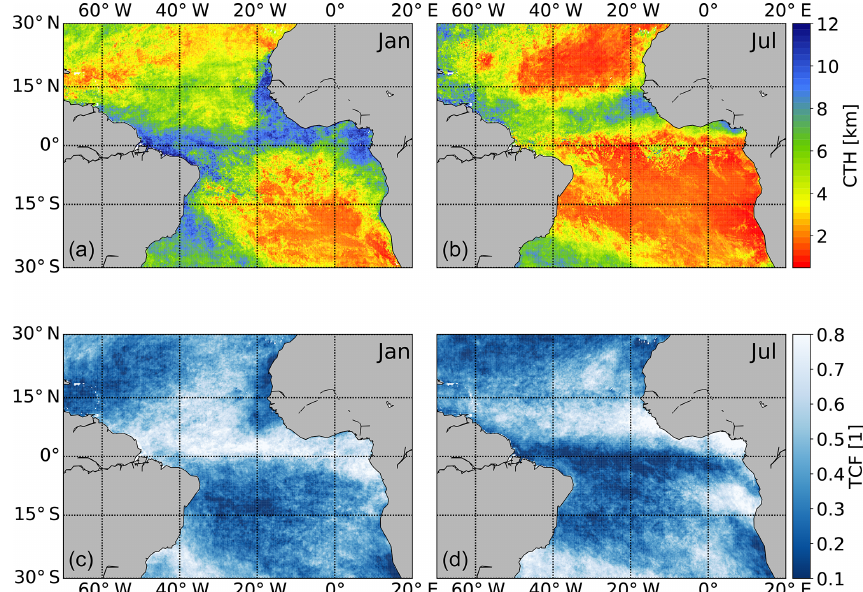
Figure 1. MODIS monthly means for the tropical Atlantic domain with a resolution of 0.2 ◦ × 0.2 ◦ for CTH (a, b) and TCF (c, d) from January (a, c) and July (b, d) 2009.